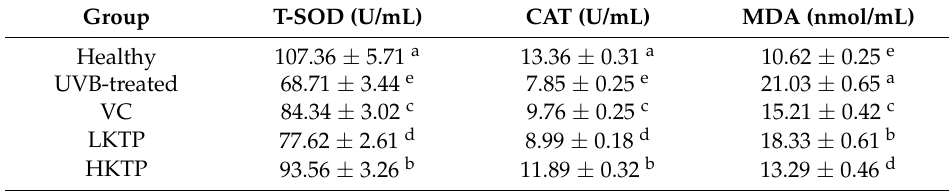
Table 2. Serum levels of T-SOD, CAT, and MDA in SKH1 hairless mice with UVB-induced skin aging. Group